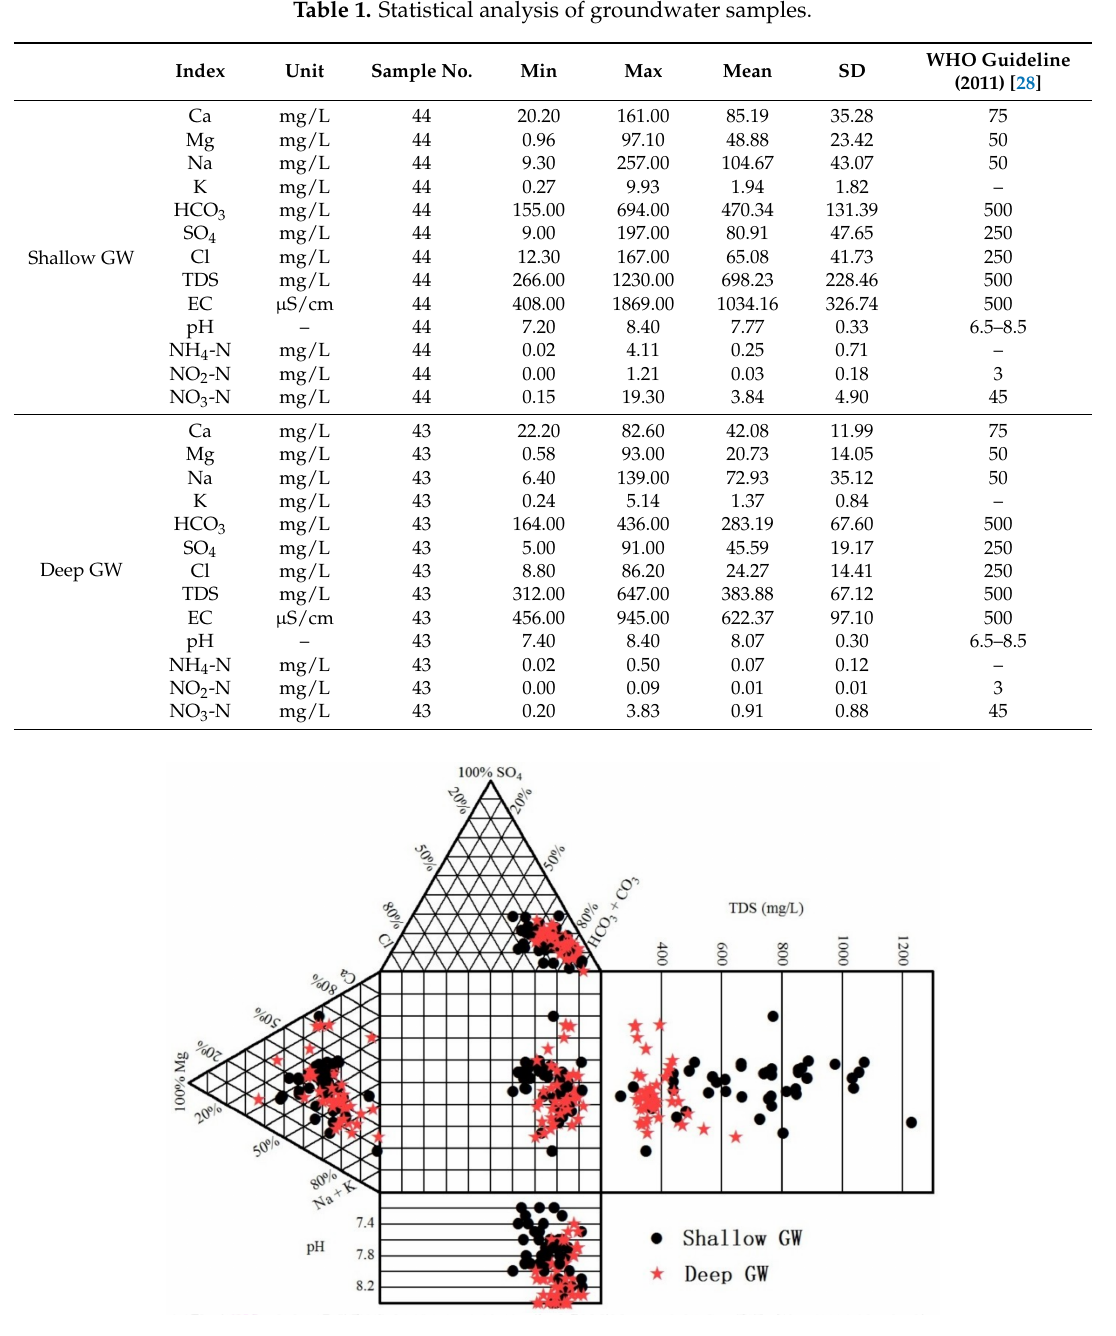
Figure 3. Durov diagram of groundwater